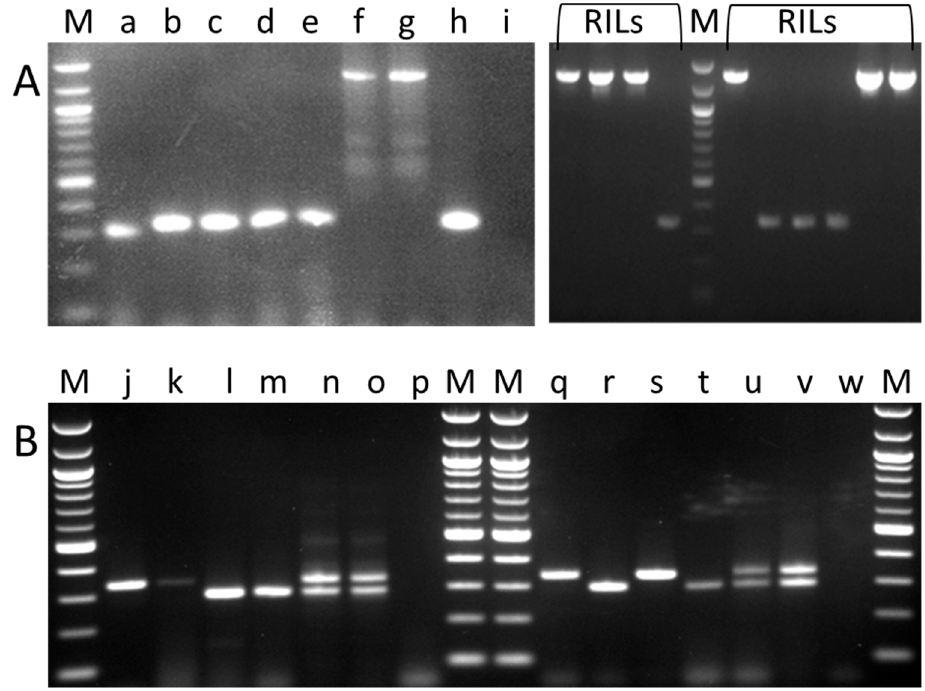
Figure 2. Diagnostic PCR tests for variant wild-type ( R ) and mutant sbeI ( r ) alleles. ( A ) Simplex PCR assays showing a 340 bp fragment, derived from the wild-type gene, and a ~1250 bp fragment, representing the mutant allele. DNA was assayed from (a) JI 2202, RR ; (b) JI 2822, RR ; (c) JI 15, RR ; (d) JI 399, RR ; (e) JI 281, RR ; (f) JI 1194, rr ; (g) JI 1201, rr ; (h) cv. Princess, marrowfat; (i) control PCR (lacking DNA). The right hand panel shows assays of recombinant inbred lines (RILs) derived from a cross between JI 15 and JI 1194; ( B ) Triplex PCR assays showing the same wild-type amplicon as shown in ( A ), with a smaller (298 bp) amplicon derived from the mutant (insertion to 3 ′ non-coding) allele, enabling heterozygotes to be scored readily. DNA was assayed from (j,k) JI 1417; (l,m) JI 1194; (n) JI 1417 × JI 1194 F1; (o) JI 1194 × JI 1417 F1; (p) control PCR (lacking DNA); (q) JI 15; (r) JI 1194; (s) JI 15; (t) JI 1194; (u,v) JI 15 and JI 1194 DNA mix; (w) control PCR (lacking DNA). Tracks labelled M show DNA markers (100 bp ladder, New England BioLabs ® , Ipswich, MA, USA). Table 1. Summary data obtained from genetic analysis of the presence or absence of the sbeI insertion mutation in a pea germplasm resource for which phenotypic data were available. The numbers of accessions scored as wild type ( SbeI-wt ), mutant ( sbeI-ins ) or heterozygous ( SbeI-wt and sbeI-ins ) among the different phenotype classes are listed.